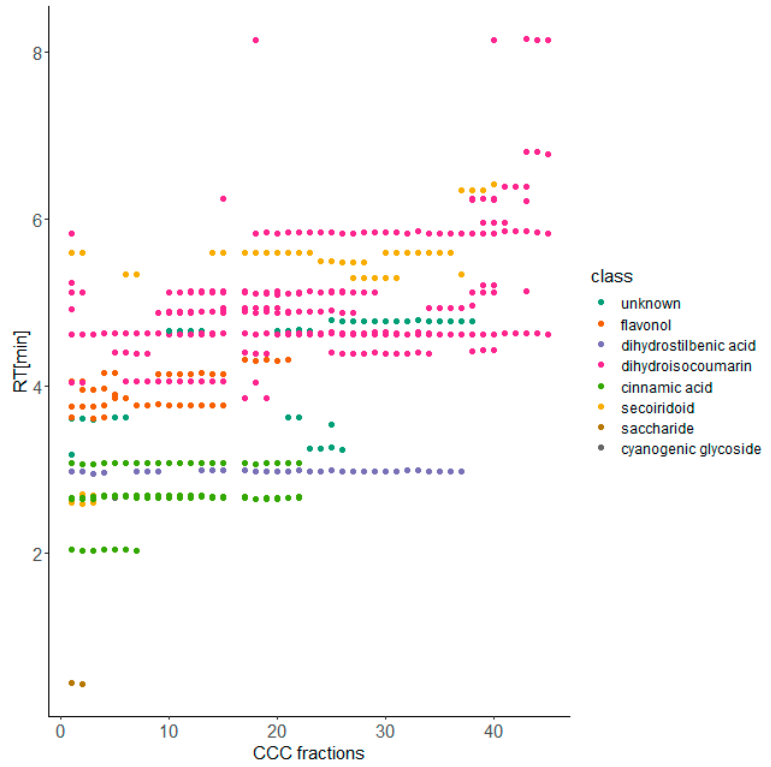
Figure 1. 2D-chromatography plot of selected natural product classes in HPCCC-fractions ( x -axis) versus LC-MS retention times ( y -axis) ( Hydrangea methanol extract XAD-16).